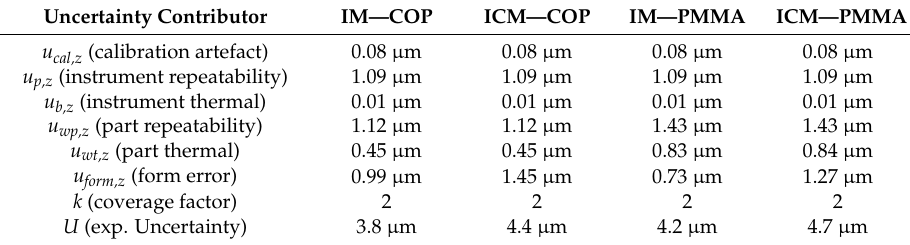
Table 3. Pitch measurements’ uncertainty budget for COP and PMMA in IM and ICM, of a nominal grooves’ width of 748.1 µ m. Measurements are calibrated with a gauge block thickness of 1500 µ